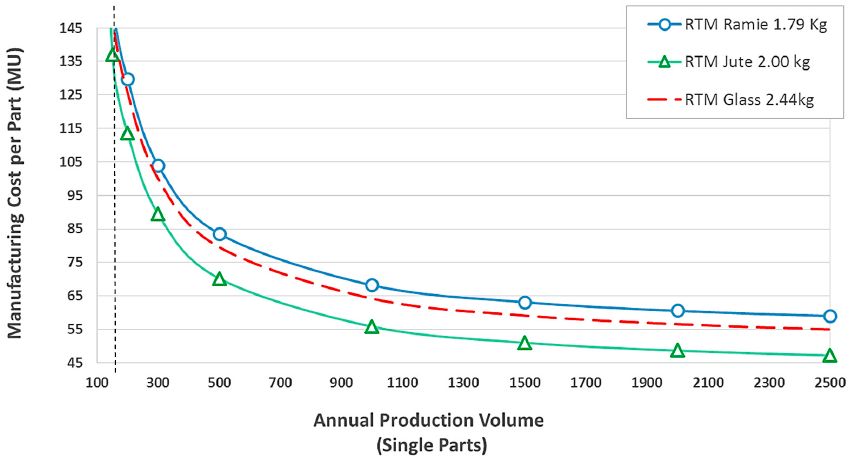
Figure 5. Hood baseline scenario against alternatives. Table 6. All costs per part for baseline and alternative scenarios.